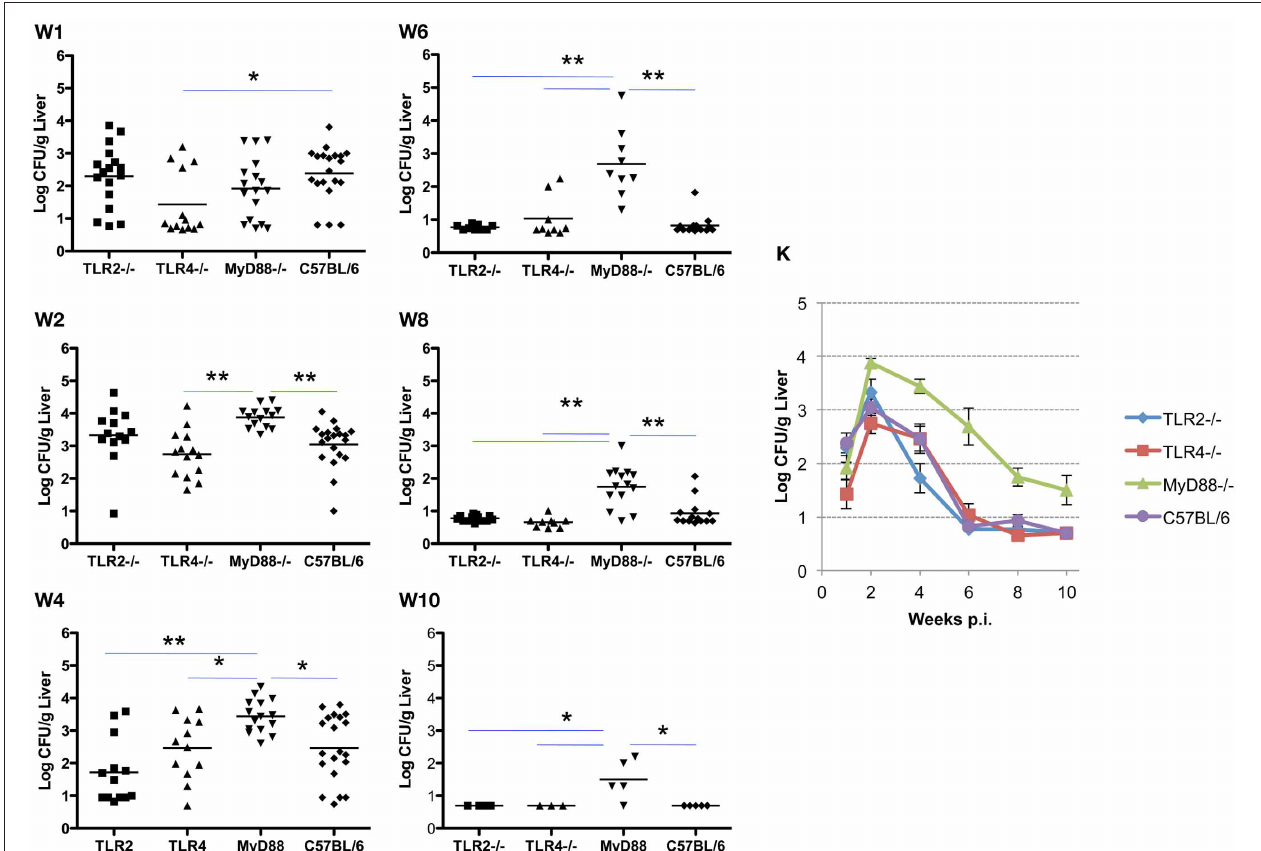
FIGURE 3 | MyD88 is required for clearance of Brucella from the livers. Groups of TLR2 − / − , TLR4 − / − , MyD88 − / − , and C57BL/6 mice were aerosol exposed to B. melitensis 16M. The livers were collected at weeks 1 (panel W1 ), 2 (panel W2 ), 4 (panel W4 ), 6 (panel W6 ), 8 (panel W8 ) and 10 (panel